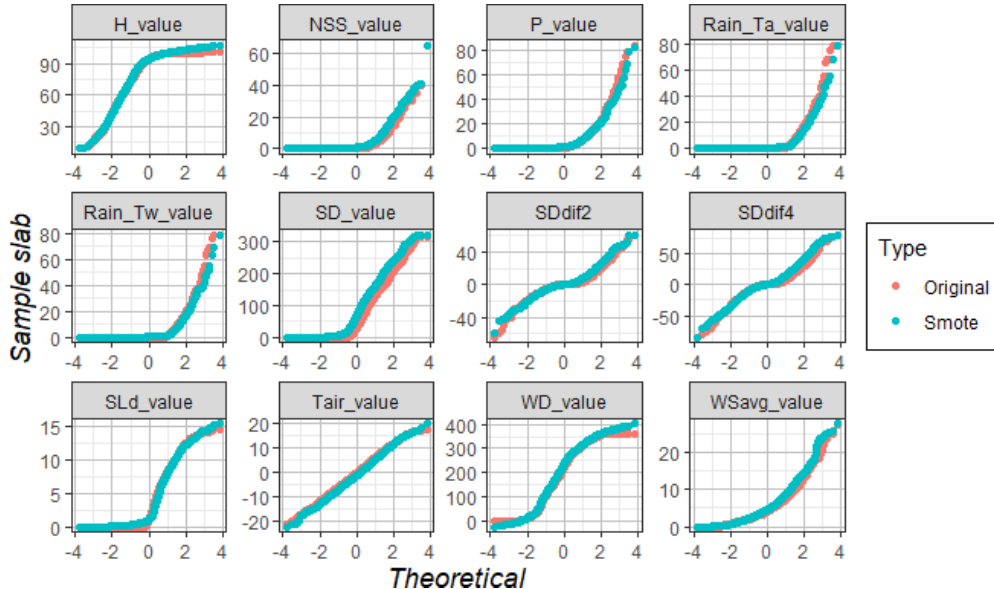
Figure A4. Quantile–quantile (Q–Q) of slab avalanches of original and synthetic data (SMOTE).